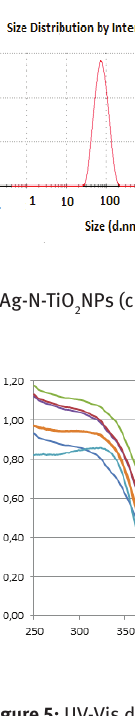
NPs and N-TiO 2